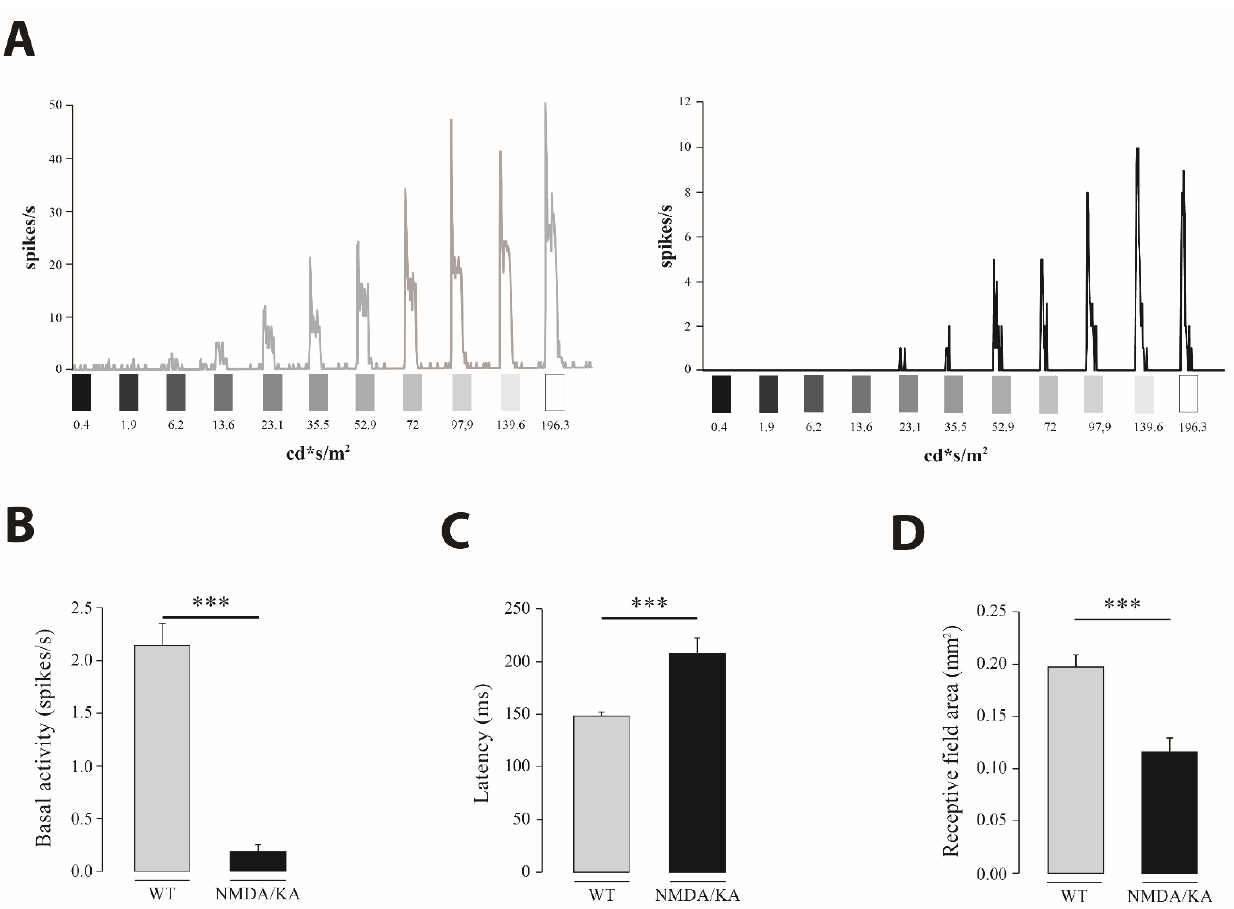
Figure 4. Quantification of the different retinal ganglion cells (RGC) types responses. ( A ). Percentages of the different functional types of RGC (ON, OFF, and ON/OFF) recorded in the control/wild type (WT retinas ( n = 4) and those injected with 10:3 mM NMDA/KA ( n = 4; t-test; p ≤ 0.001 for ON and ON/OFF cells). A significant decrease in the number recorded cells was observed for the NMDN/KA injected retinas (t-test; p = 0.018). The total number of ON, OFF, and ON/OFF cells were 89, 35, and 113 for the WT retinas and 48, 2, and 0 for NMDA/KA injected eyes, respectively. Data are presented as mean ± SEM. ( B ). Examples of sustained (left) and transient (right) post stimulus raster plot of light responses are represented for each RGC type (ON, OFF, and ON/OFF) for both retinas from the WT/control animals and those injected with NMDA/KA. The light stimulus is represented above the plots. A corresponding cumulated post stimulus time histogram (PSTH) for all recording examples is also shown for all RGC types. The firing frequency evoked by the light stimulus is greatly reduced in the NMDA/KA group. (***, p ≤ 0.001).